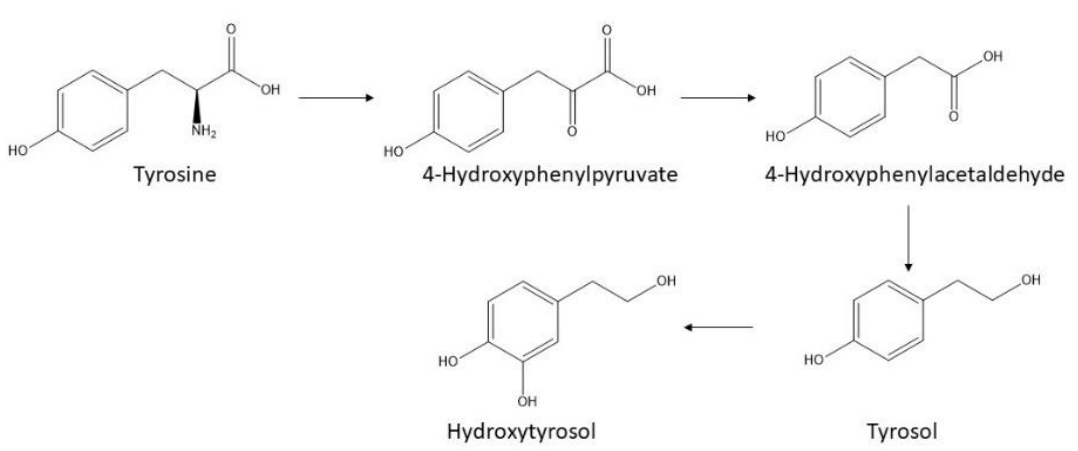
Figure 3. Illustration of the biosynthetic pathway of hydroxytyrosol (3,4-dihydroxyphenethyl alcohol, DOPET, 3-hydroxytyrosol, and homoprotocatechuyl alcohol. The empirical formula of hydrox- ytyrosol is C 8 H 10 O 3 and it has a molecular weight of 154.16 g/mol) from tyrosine for different organ- isms.